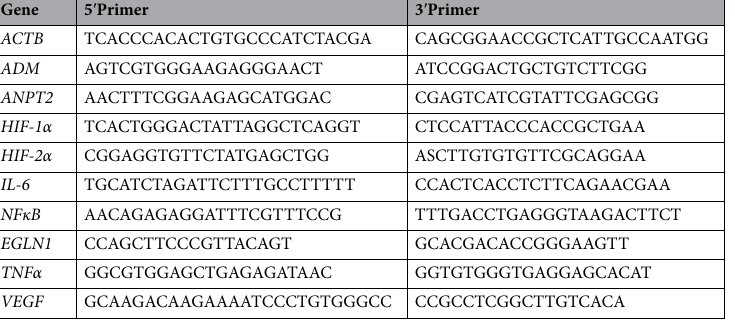
Table 2. Human primer sequences. Primer sequences of specific PCR products used for RNA quantifications of human whole blood via